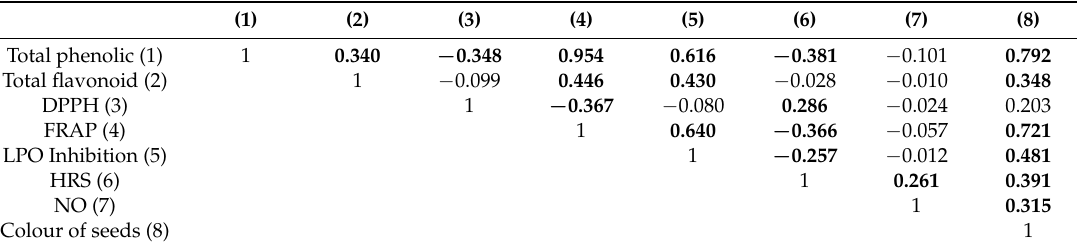
Table 2. Pearson correlation